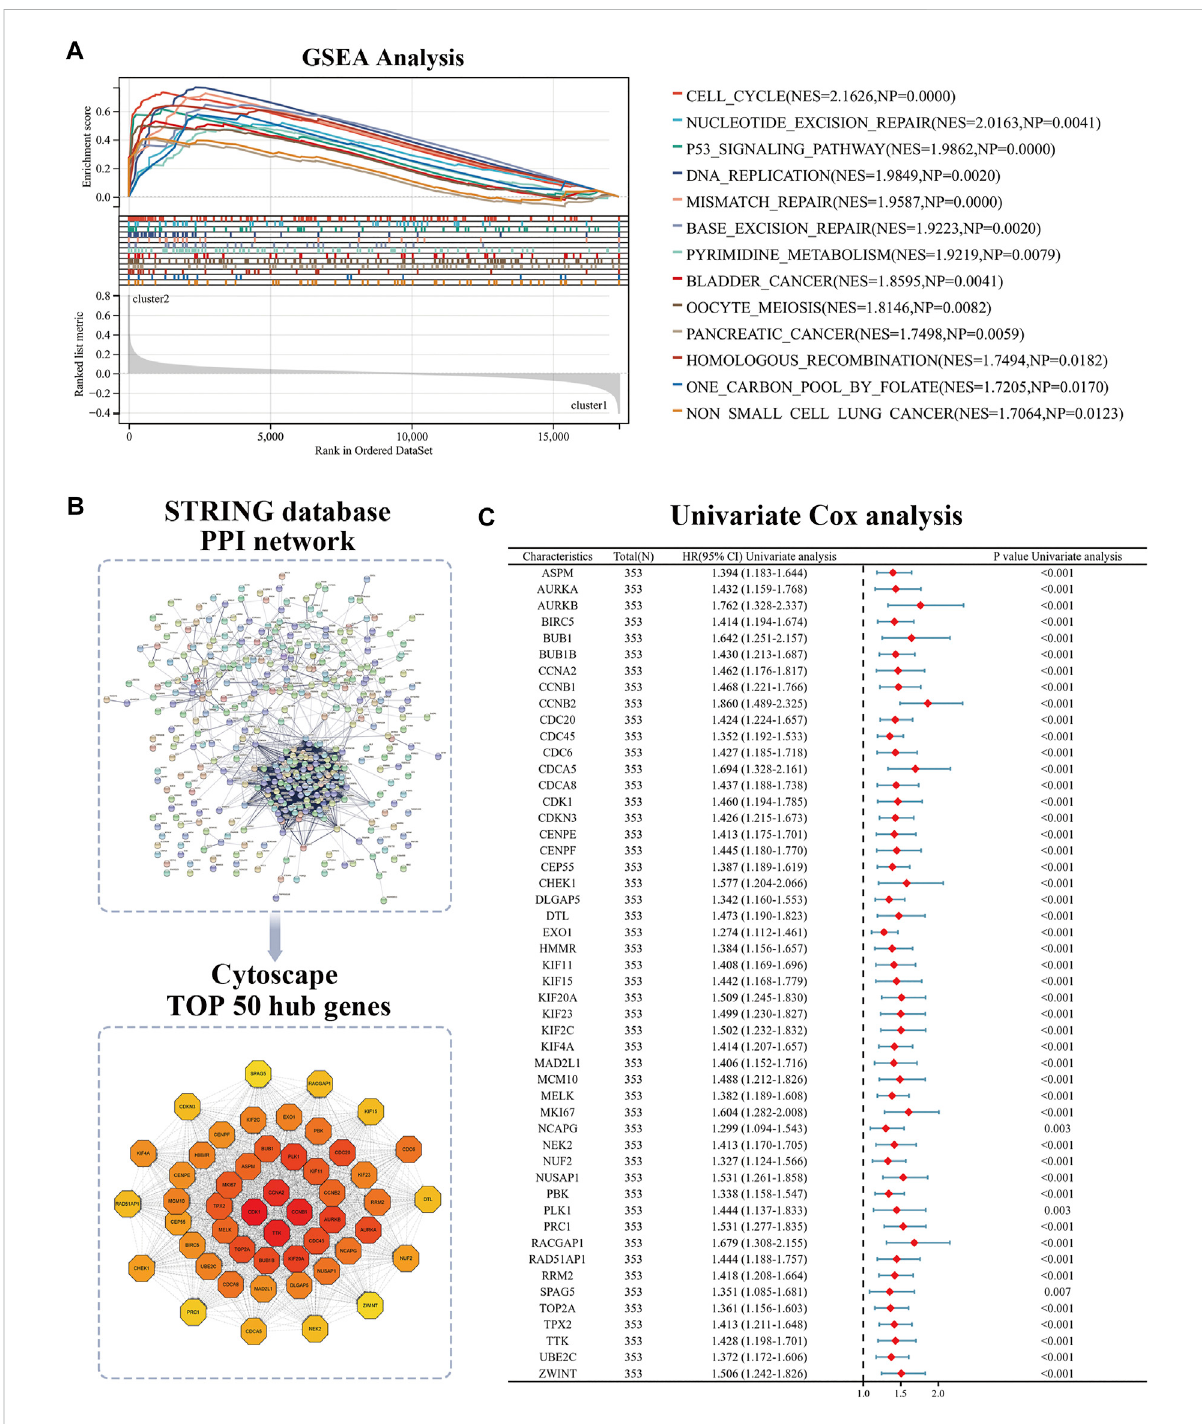
FIGURE 3 Identi fi cationhubgenesinPPInetwork. (A) GSEAanalysisoftwopatterns; (B) TheSTRINGdatabaseandCytoscapesoftwarewasusedtoobtain hub CR-DEGs; (C) The hub 50-DEGs analyzed by Univariate Cox regression. PPI: Protein-Protein Interaction; GSEA: Gene Set Enrichment